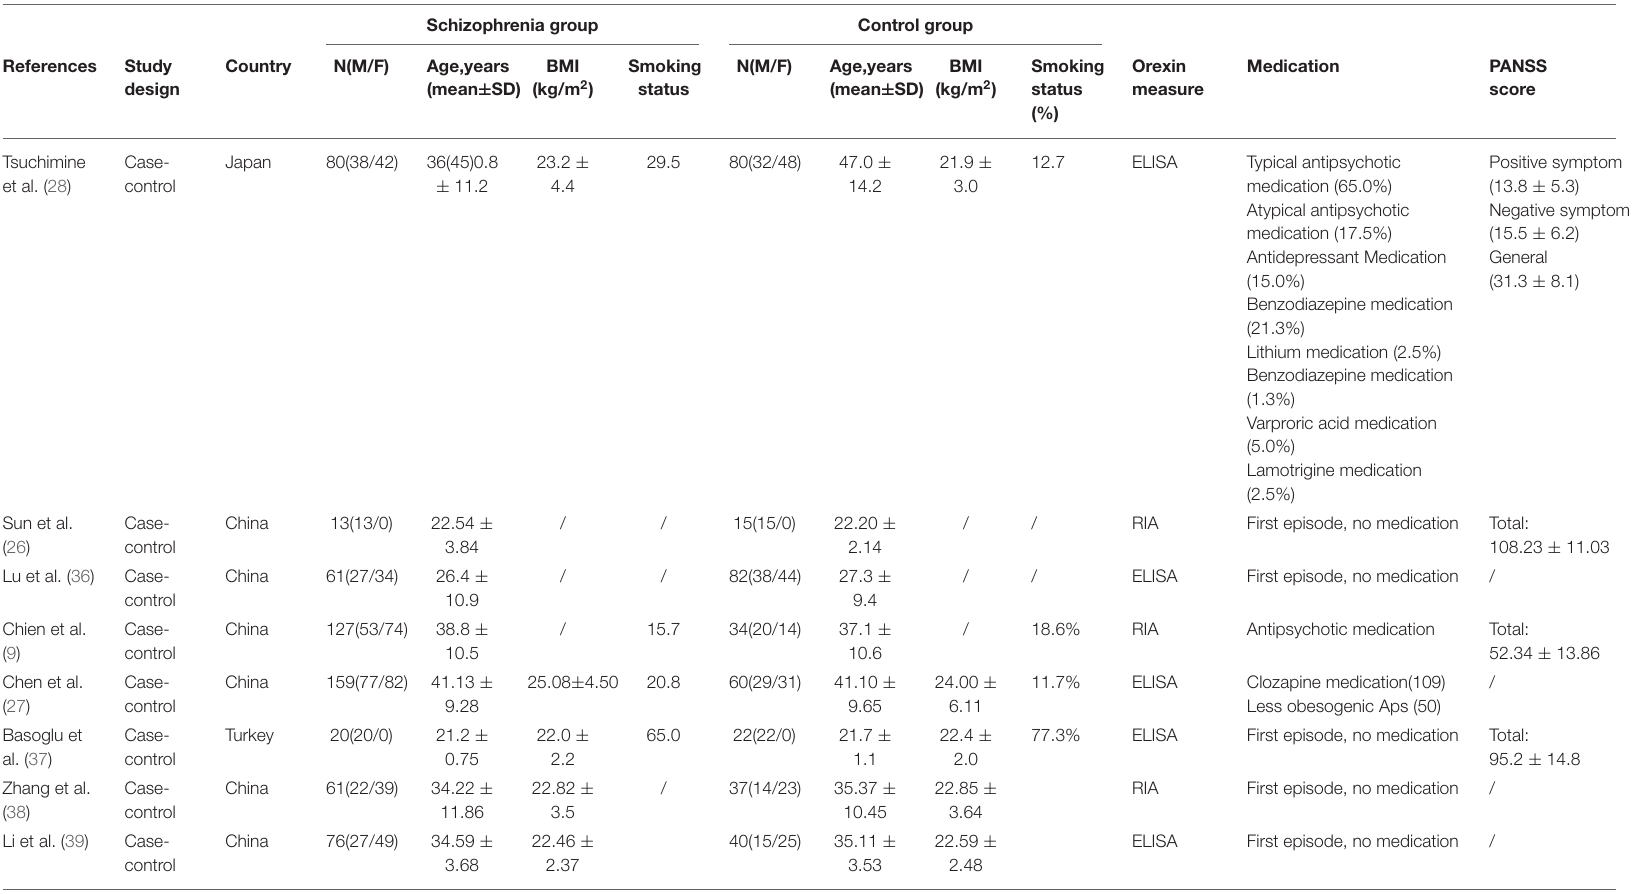
TABLE 1 | Characteristics of included studies in the meta-analysis for plasma orexin-A